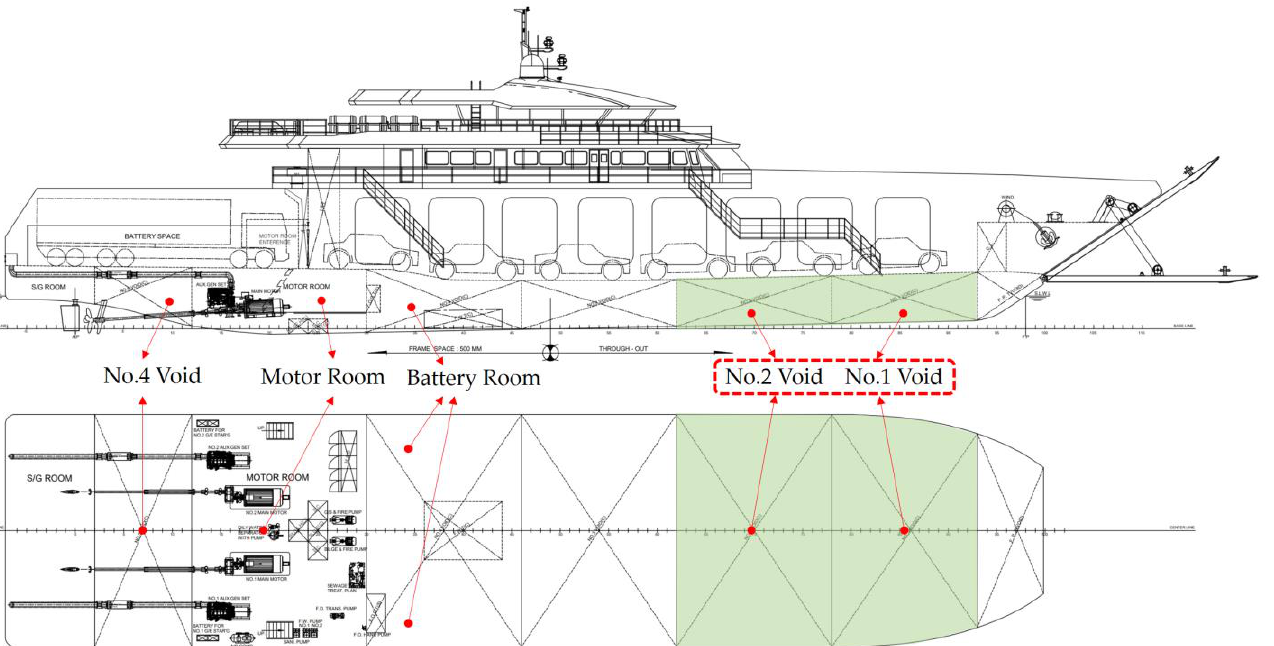
Table 4. Examples of flooding accident cases where the target ship may sink.